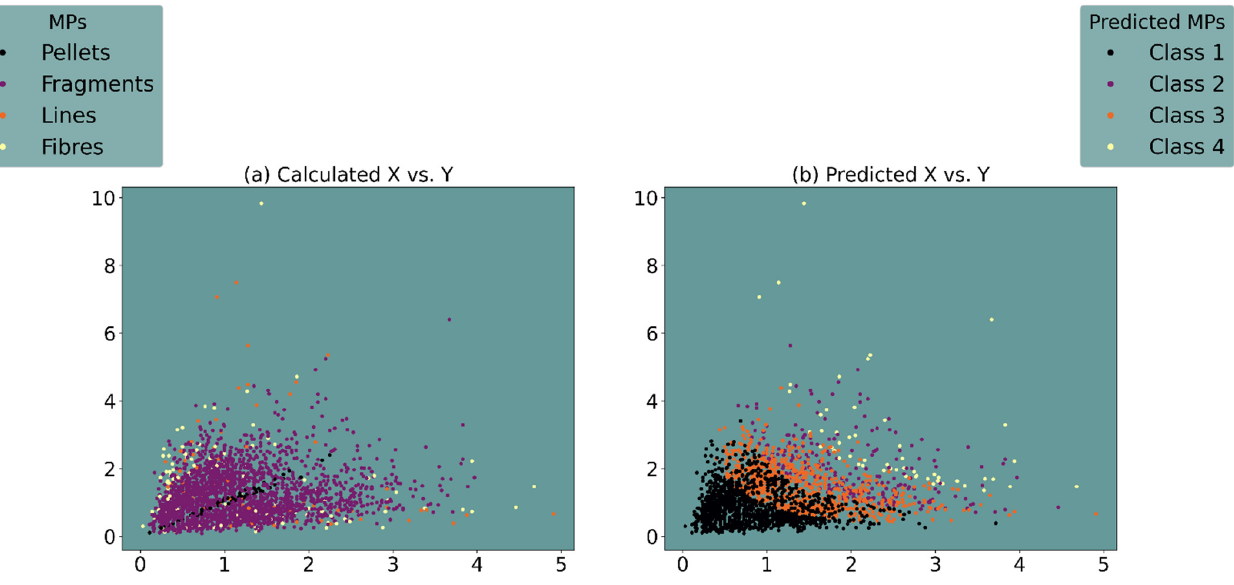
Figure 8. Plotted results of unsupervised classification. The “Calculated” column on the left ( a-c-e ) refers to output data from a human expert, while the “Predicted” column ( b-d-f ) refers to values from unsupervised classification.